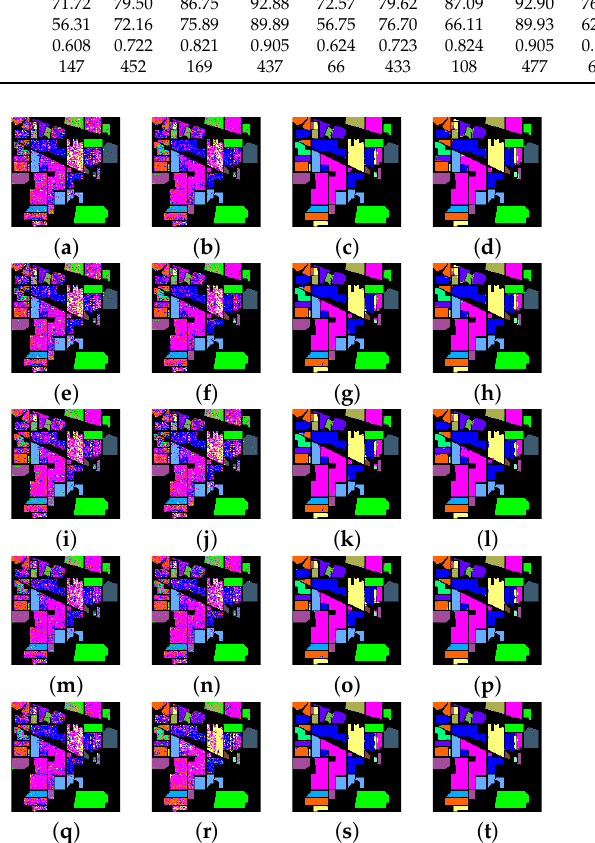
Figure 4. Classification maps for the Indian Pines data set. ( a ) (cid:96) 2 + (cid:96) 1 ; ( b ) (cid:96) 2 + (cid:96) 1 +NC; ( c ) (cid:96) 2 + (cid:96) 1 +SF; ( d ) (cid:96) 2 + (cid:96) 1 +SF+NC; ( e ) (cid:96) 1 + (cid:96) 1 ; ( f ) (cid:96) 1 + (cid:96) 1 +NC; ( g ) (cid:96) 1 + (cid:96) 1 +SF; ( h ) (cid:96) 1 + (cid:96) 1 +SF+NC; ( i ) F + (cid:96) 1 ; ( j ) F + (cid:96) 1 +NC; ( k ) F + (cid:96) 1 +SF; ( l ) F + (cid:96) 1 +SF+NC; ( m ) F + (cid:96) 2,1 ; ( n ) F + (cid:96) 2,1 +NC; ( o ) F + (cid:96) 2,1 +SF; ( p ) F + (cid:96) 2,1 +SF+NC; ( q ) (cid:96) 2,1 + (cid:96) 2,1 ; ( r ) (cid:96) 2,1 + (cid:96) 2,1 +NC; ( s ) (cid:96) 2,1 + (cid:96) 2,1 +SF; ( t ) (cid:96) 2,1 + (cid:96) 2,1 +SF+NC